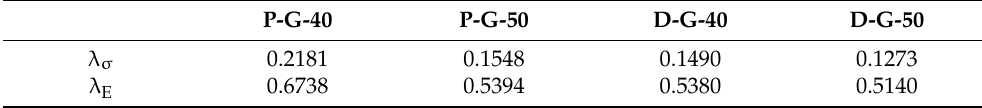
Table 8. Fiber efficiency factors of GP 1100A